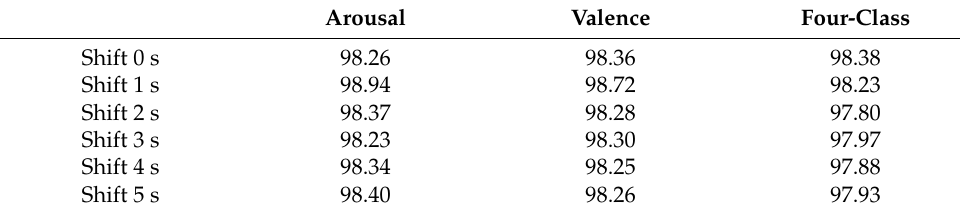
Table 5. Classification results on different starting points of the signals.